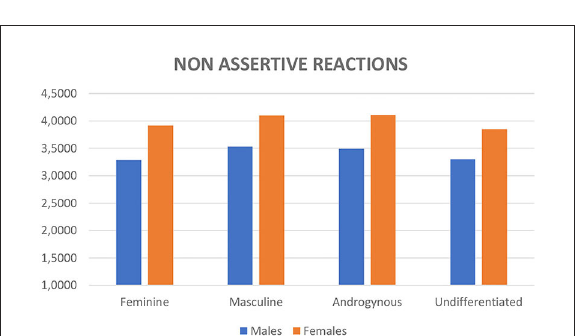
FIGURE2 Mean scores of assertive reactions divided for sex and gender role according to the Bem (1974) theory.